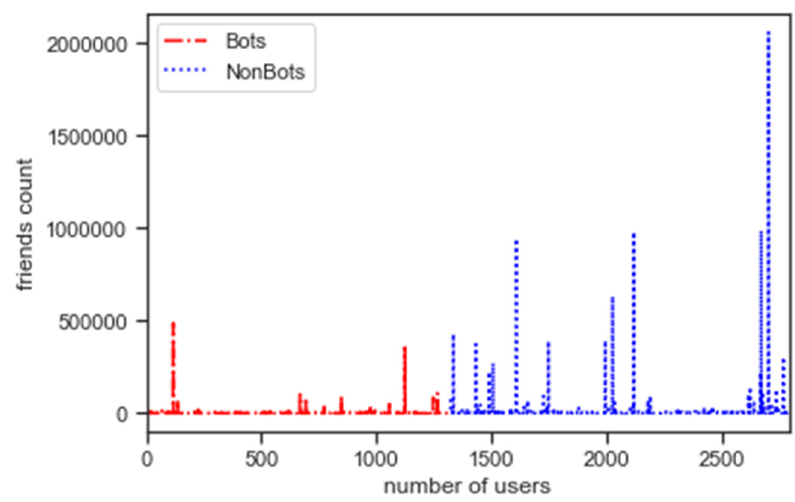
Figure 13. Numbers of Users against friends count.